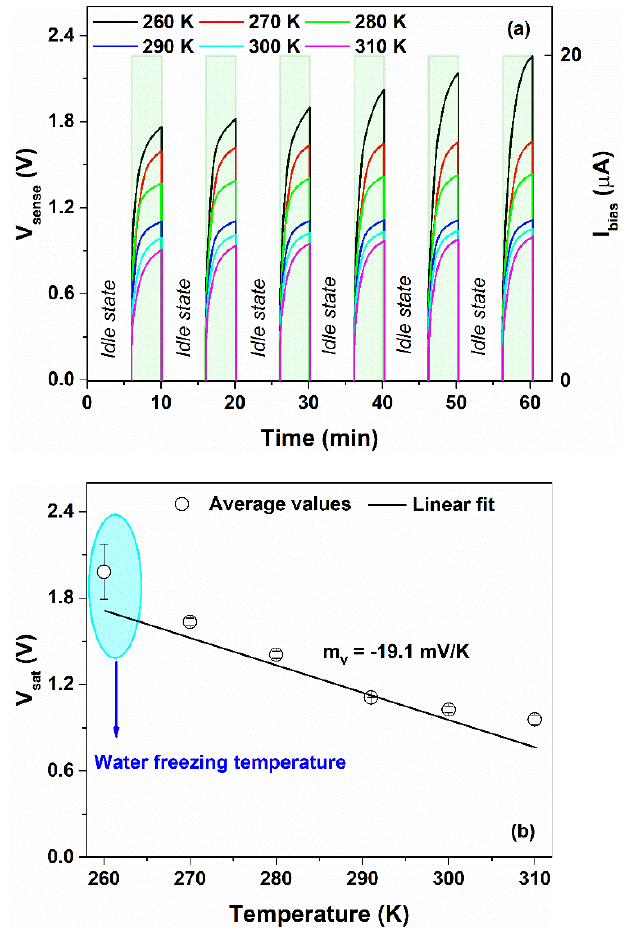
Figure 14. ( a ) Time evolution of the voltage across the device (y-left axis) and corresponding bias current profile (y-right axis), measured by using the logic circuit. ( b ) Variation in the output voltage as a function of the temperature for bias current of 20 μ A. The solid line represents the linear fit.